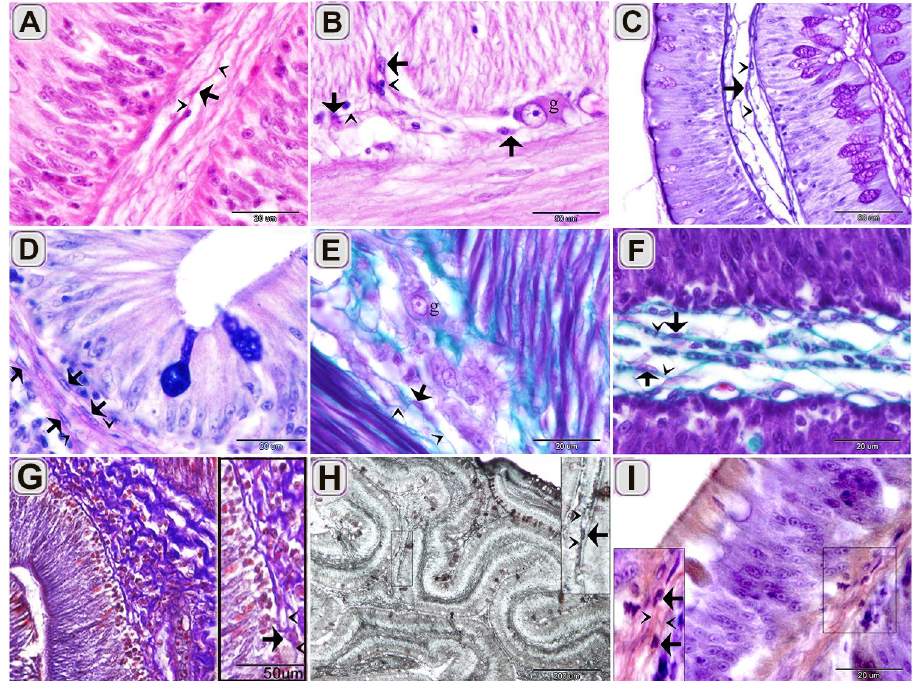
Figure 3. Recognition of TCs using HE, PAS, AB pH 2.5/PAS, Crossmon trichrome, Mallory triple trichrome , Sudan black, osmic acid. Paraffin sections of the intestinal blub stained by HE ( A , B ), PAS/Hx ( C ), AB ph 2.5/ PAS ( D ), Crossmon trichrome ( E , F ), Mallory triple trichrome ( G ), Sudan black ( H ), osmic acid ( I ). ( A ) The cell body of TC (arrow) in the lamina propria was recognized by telopodes. Telopodes (arrowheads). ( B ) The cell body of TCs (arrows) around the ganglionic cell (g) of the myenteric plexus. Telopodes (arrowheads). ( C ) TC stained positively for PAS. Telopodes (arrowheads). ( D ) TC had a strong affinity for PAS rather than AB. Telopodes (arrowheads). ( E ) The cell body of TCs (arrows) stained green by Crossmon trichrome. Note the ganglionic cell (g) of the myenteric plexus. ( F ) TC (arrow) in the lamina propria stained green by crossmon trichrome. Telopodes (arrows). ( G ) The cell body of TCs (arrows) stained blue by Mallory triple. Telopodes (arrowheads). ( H ) The cell body of TC (arrow) stained black by Sudan black. Telopodes (arrowheads). ( I ) The cell body of TC (arrow) stained brown by osmic acid. Telopodes